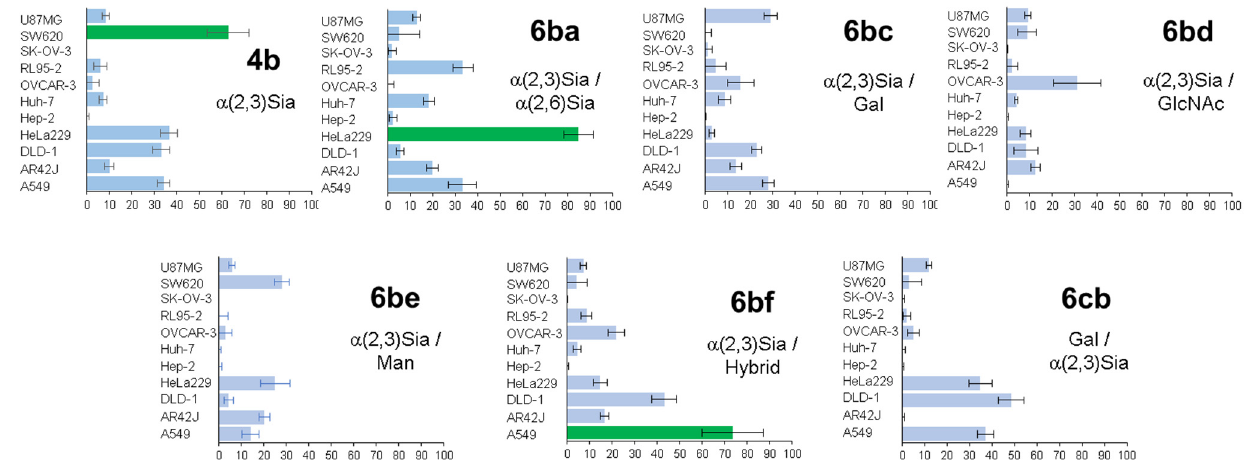
Figure 7. Study of homogeneous glycoalbumin 4b and heterogeneous glycoalbumins 6ba – cb (100 nM) against 11 different cell lines performed with cell-based assay via fluorescence: green bars—strong binding; blue bars—moderate or negligible binding. Reproduced from [47], with permission from the Royal Society of Chemistry.